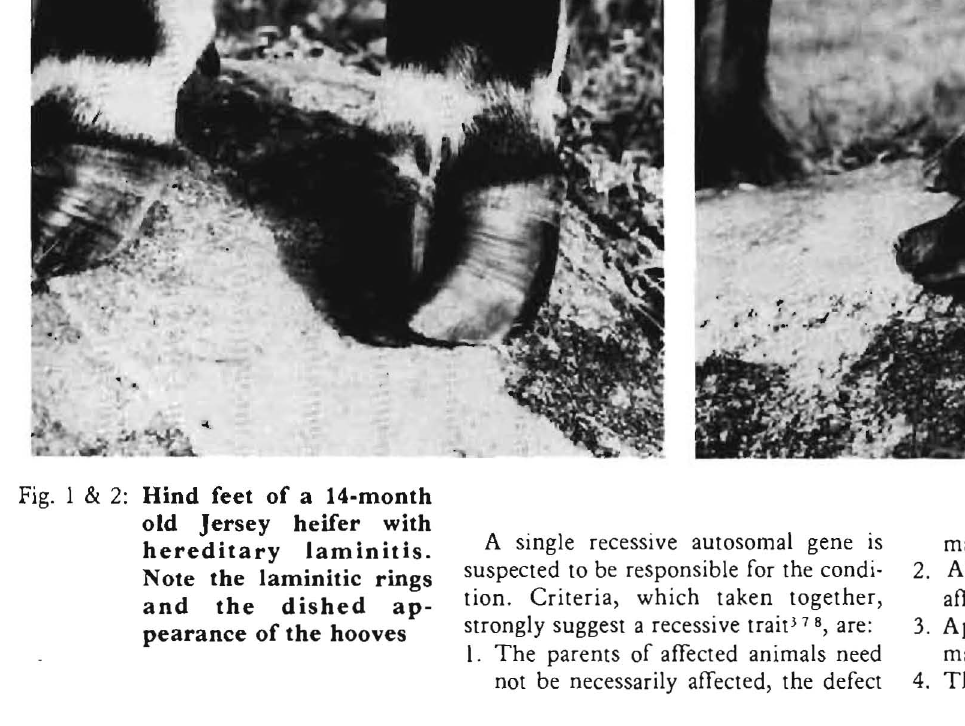
Fig. 1 & 2: Hind feet of a 14-month old Jersey heifer with hereditary laminitis. Note the laminitic rings and the dished ap